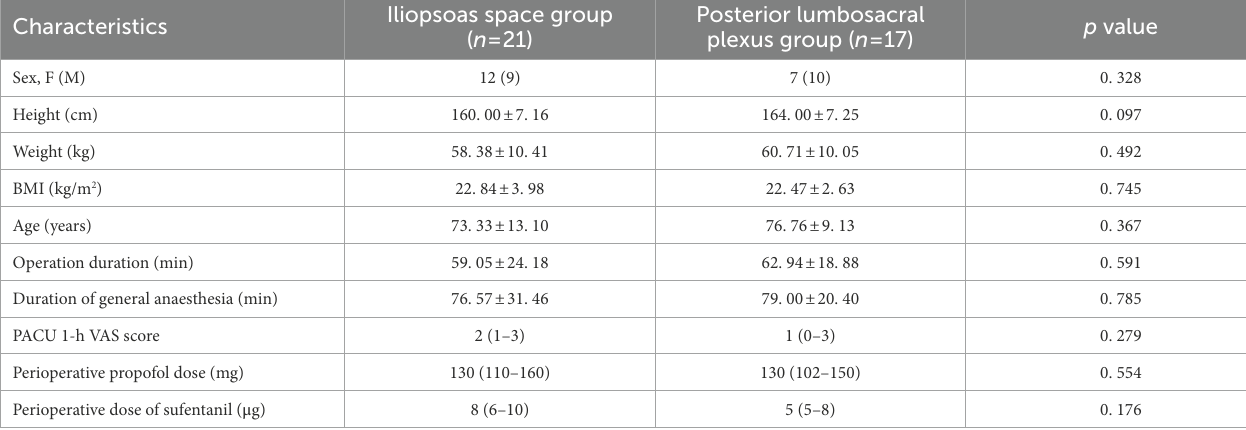
TABLE 1 General patient and surgery